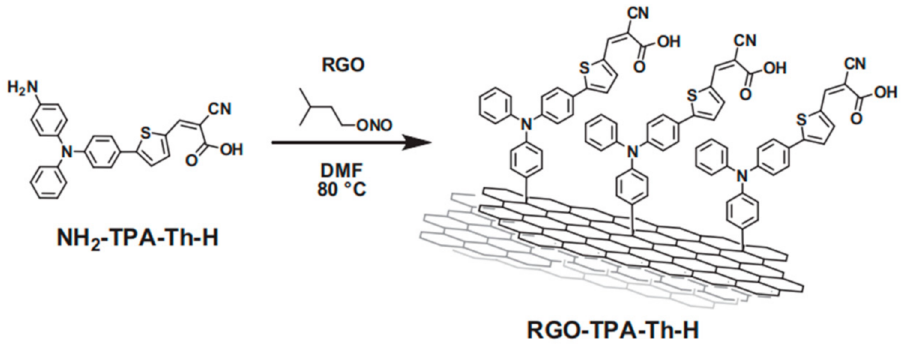
Figure 1. Functionalization of RGO with the donor– π –acceptor system to furnish the new hybrid species. Reproduced from [54] with the permission of